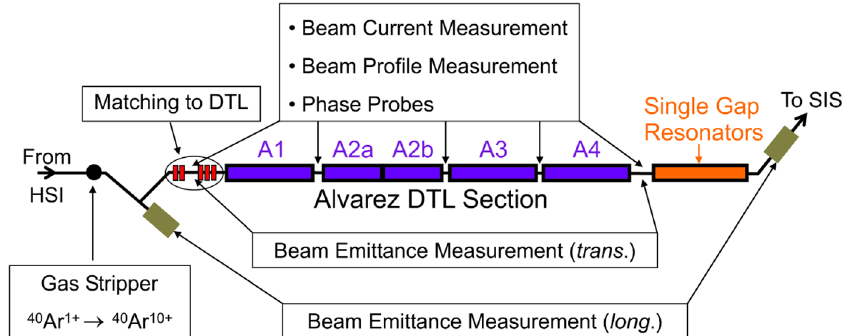
FIG. 3. (Color) Schematic setup of the